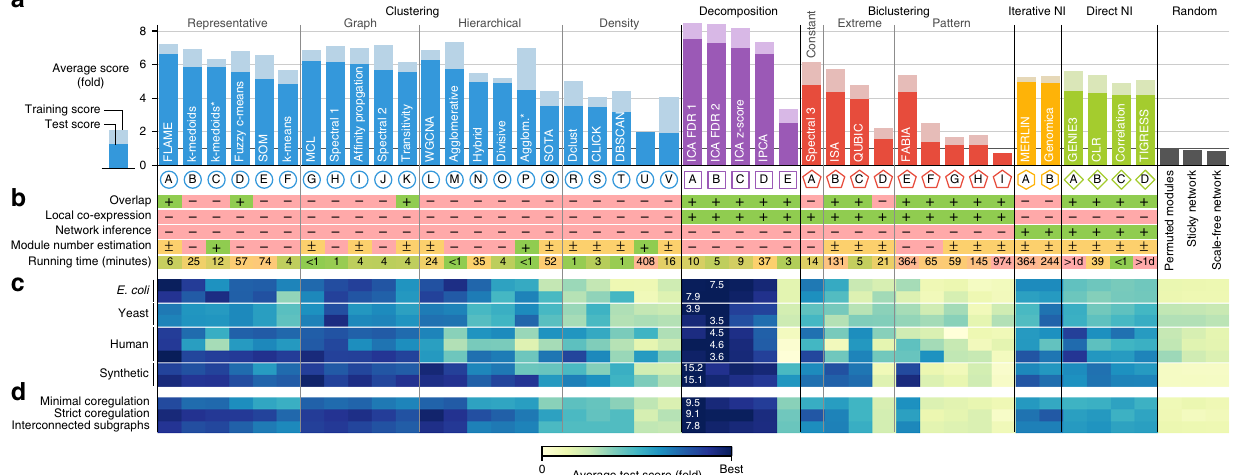
Fig. 2 Overall performance of 42 module detection methods (Table 1) based on the agreement between observed modules and known modules in gene regulatory networks. The methods can be divided in fi ve categories: clustering, decomposition, biclustering, direct network inference (direct NI) and iterative network inference (iterative NI) methods. Clustering and biclustering methods were further classi fi ed in subcategories (see Methods). a Average test and training scores across datasets and module de fi nitions. The score represents a fold improvement over permutations of the known modules. *Automatic estimation of number of modules. b Different properties of the module detection methods (see Supplementary Note 2). A + (green background) denotes that a method can handle a certain property listed on the left. We distinguish between explicit ( − ), implicit (±), and automatic ( + ) module number estimation. Note that running times strongly depend on the implementation, hardware, dataset dimensions, and parameter settings, and are therefore only indicative. c Test scores at each of the four datasets, averaged over module de fi nitions. d Test scores on each of the three module de fi nitions, averaged over different